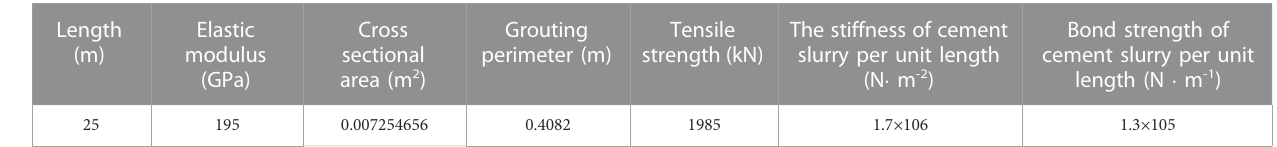
TABLE 3 Anchor parameters.